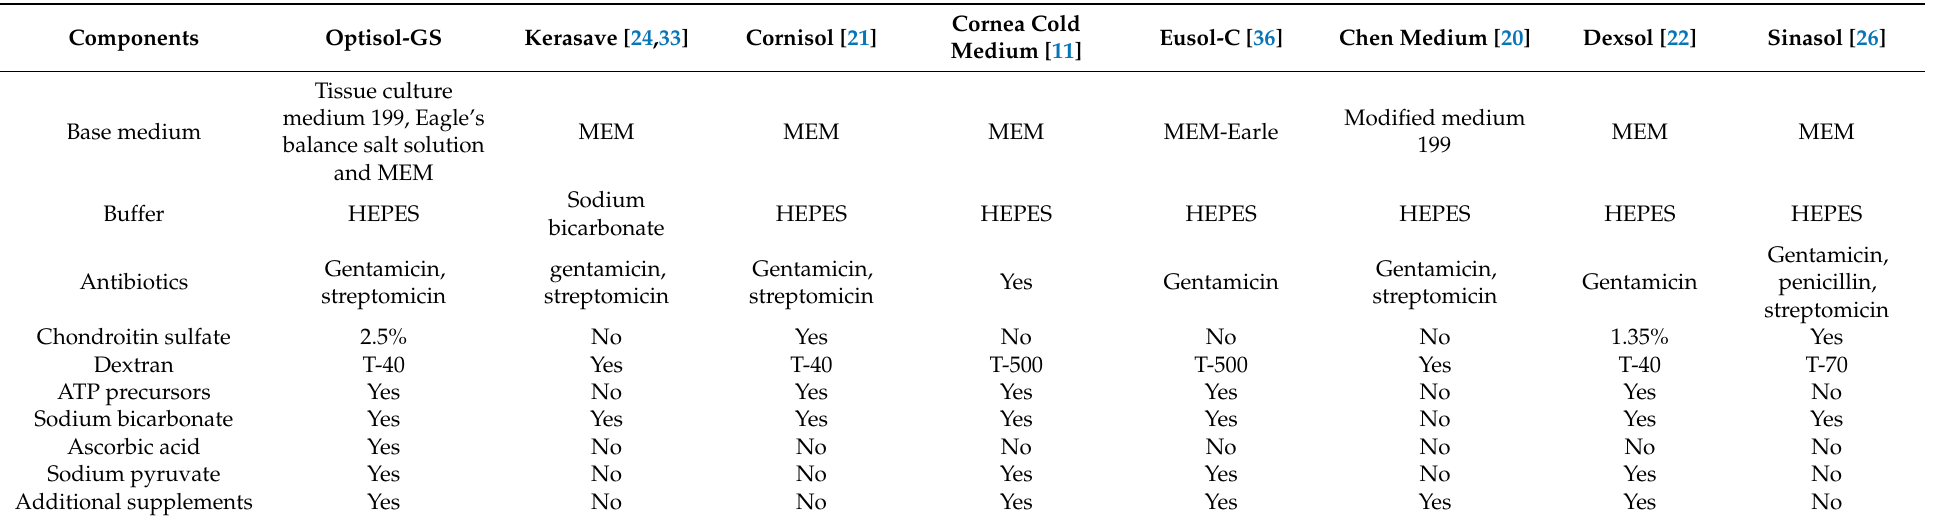
Table 5. List of commercial preservation media and their